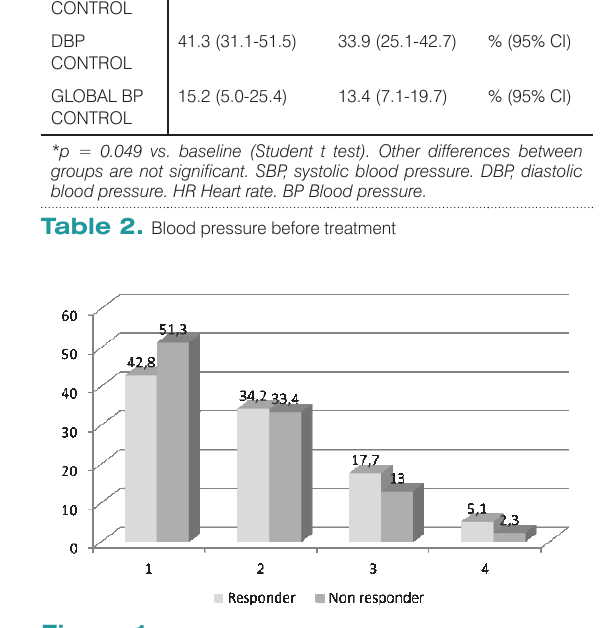
Figure 1. Number of antihypertensive drugs used. Differences between groups are not significant.